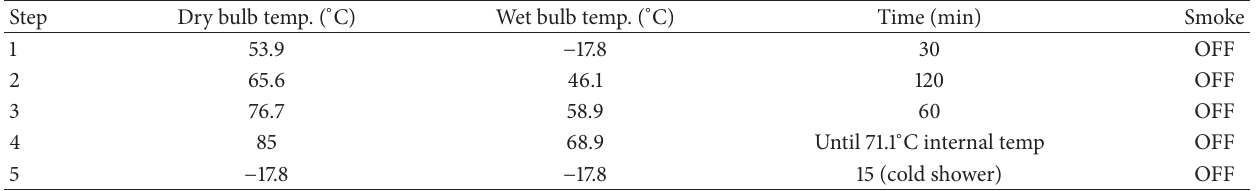
Table 1: Dry bulb temperatures, wet bulb temperatures, time, and smoke setting for each step used in the turkey deli loaf smoke cycle.